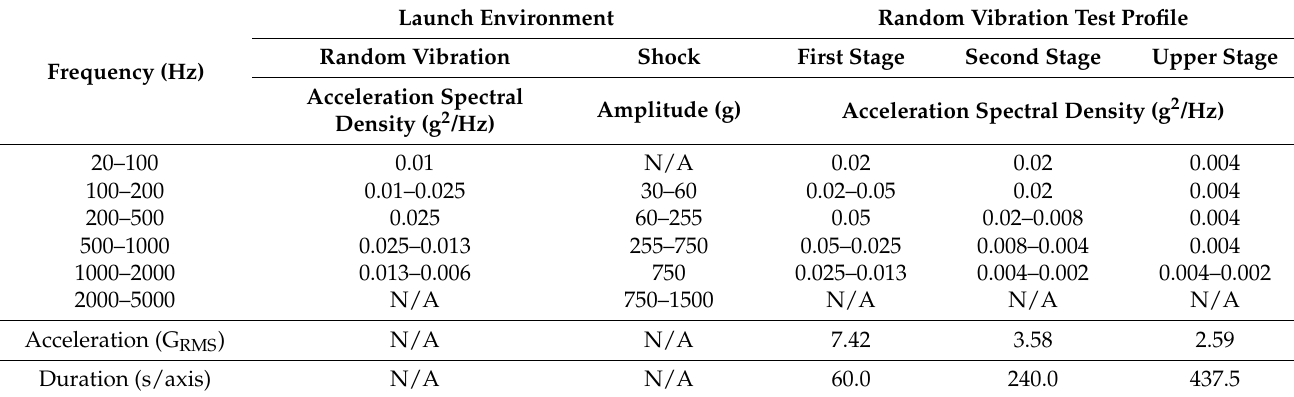
Table 1. Soyuz-2.1a launch environment characteristics and random vibration test